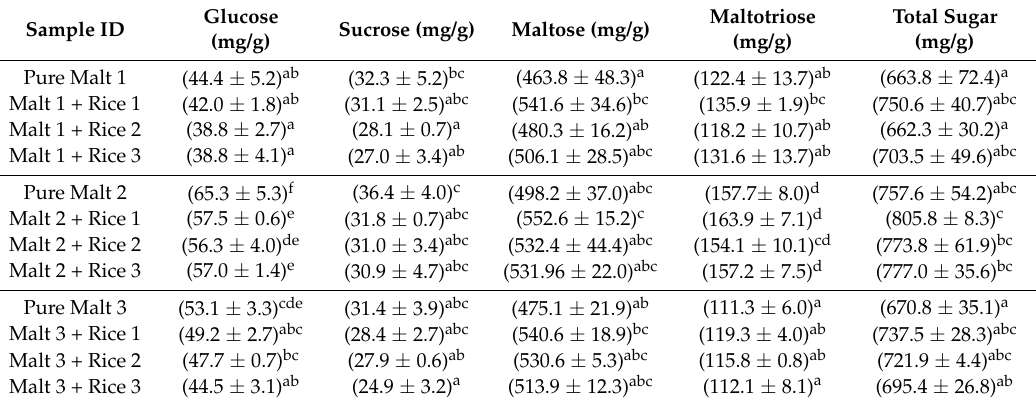
Table 2. The content of fermentable sugars in the wort after mashing 1,2